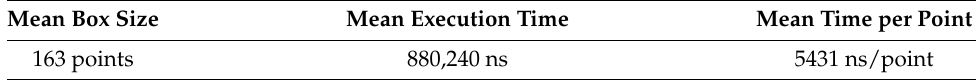
Table 5. Results from hardware “points to voxels” module.